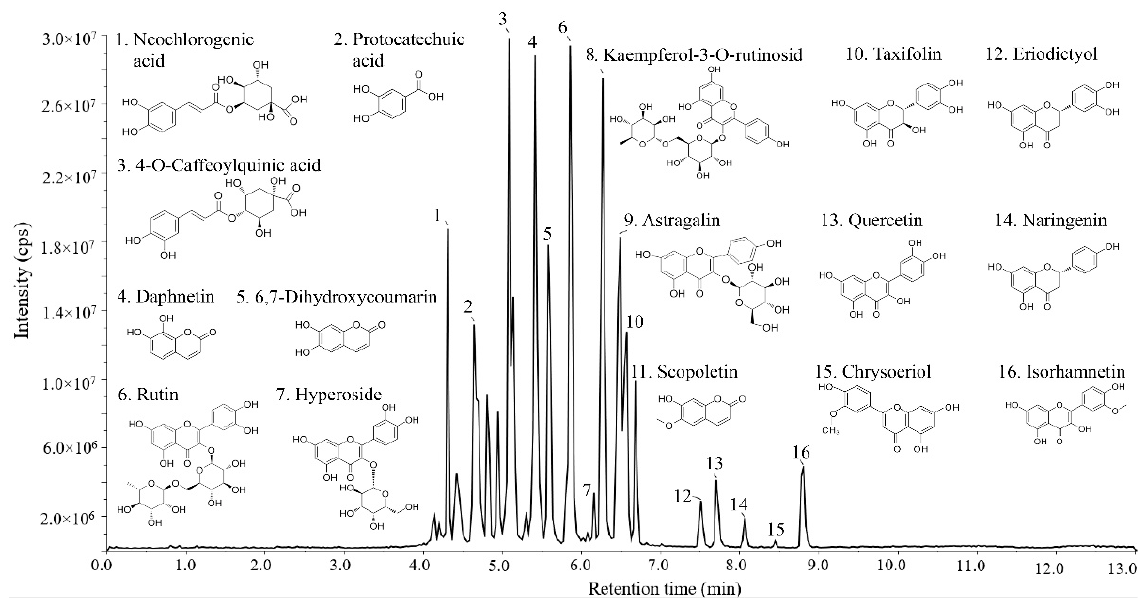
Figure 2. Total ion current chromatogram of sample solution by LC–MS. The names and molecular formulas of 16 compounds identified in the extract of flavonoids from the fruits of Lycium barbarum .